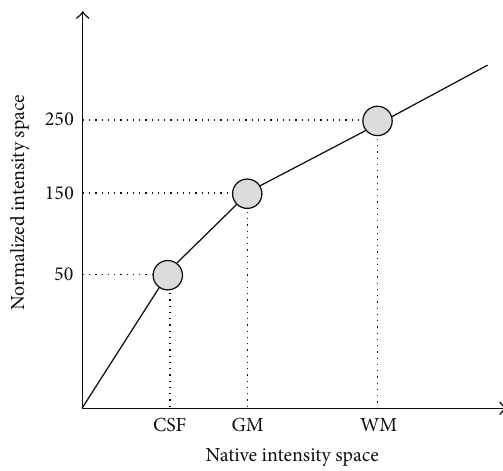
Figure 1: Proposed intensity normalization via a piecewise lin- ear mapping. CSF, GM, and WM mean values are automatically estimated using TMS method and mapped to their corresponding normalized values (50, 150, and